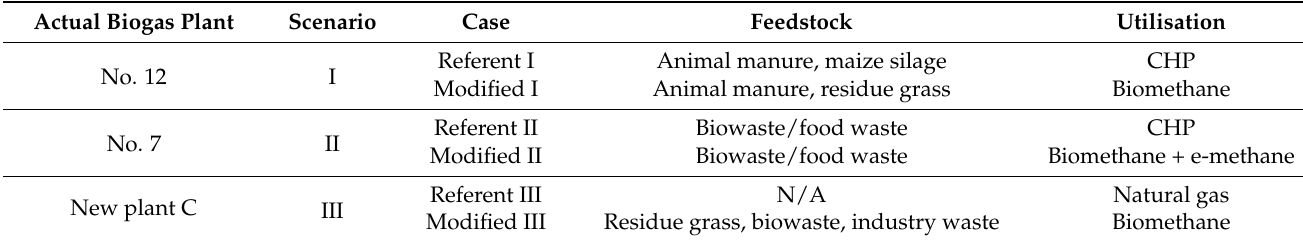
Table 7. Biomethane production potential in newly planned biogas plants in the case